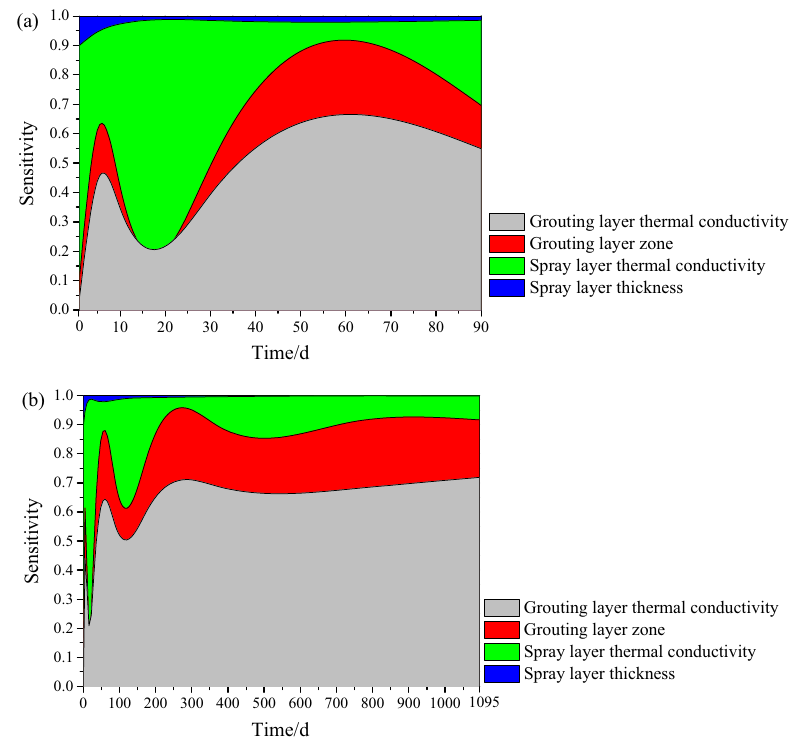
Figure 21: Sensitivities of different influencing factors on heat - adjusting zone radius: ( a ) 90 days; ( b ) 1,095